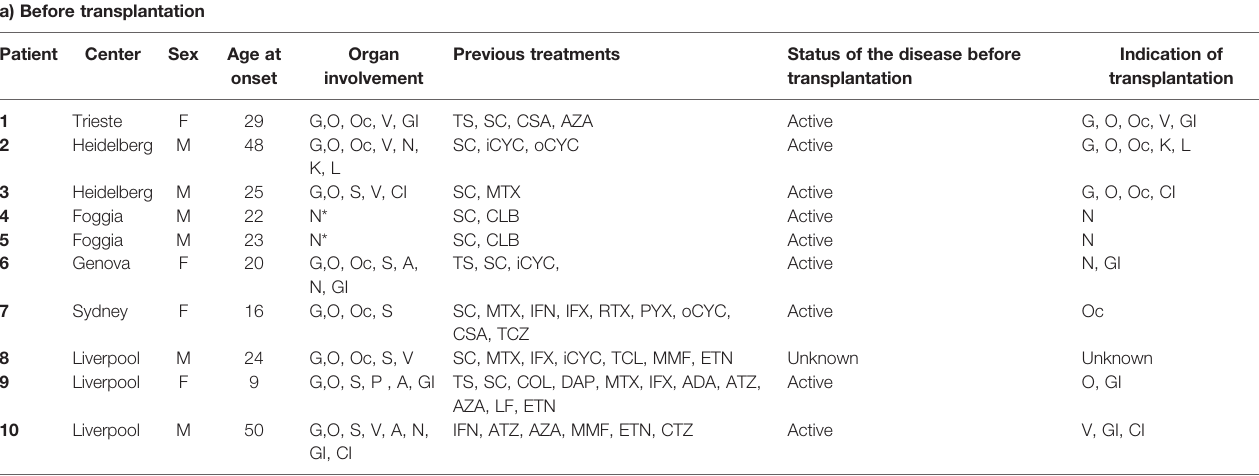
*patients extracted from the literature, ful fi lling International Study Group criteria of Behcet ’ s Disease. A, Arthritis; ADA, Adalimumab; ATZ, Alemtuzumab; AZA, Aziathoprine; CI, Cardiac Involvement; CLB, Chlorambucil; COL, Colchicine; CSA, Cyclosporine; CTZ, Certolizumab; DAP, Dapsone; ETN, Etanercept; FU, Follow-up; iCYC. intravenous Cyclophosphamide; IFX, In fl iximab; IFN, Interferon alpha; G, Genital aphtosis; GI, Gastro-Intestinal Involvement; K, Kidney; L, Lung; LF, Le fl unomide; MMF, Mycophenolate Mofetil; MTX, Methotrexate; N, Neurological involvement; O, Oral aphtosis; Oc, Ocular involvement; oCYC, Oral Cyclophosphamide; P, Pathergy test positive; PYX, Pentoxifylline; RTX, Rituximab; S, Skin involvement (skin ulcer or erythema nodosum); SC, Systemic Corticoids; TCL, Tacrolimus; TCZ, Tocilizumab; TS, Topical Steroids.